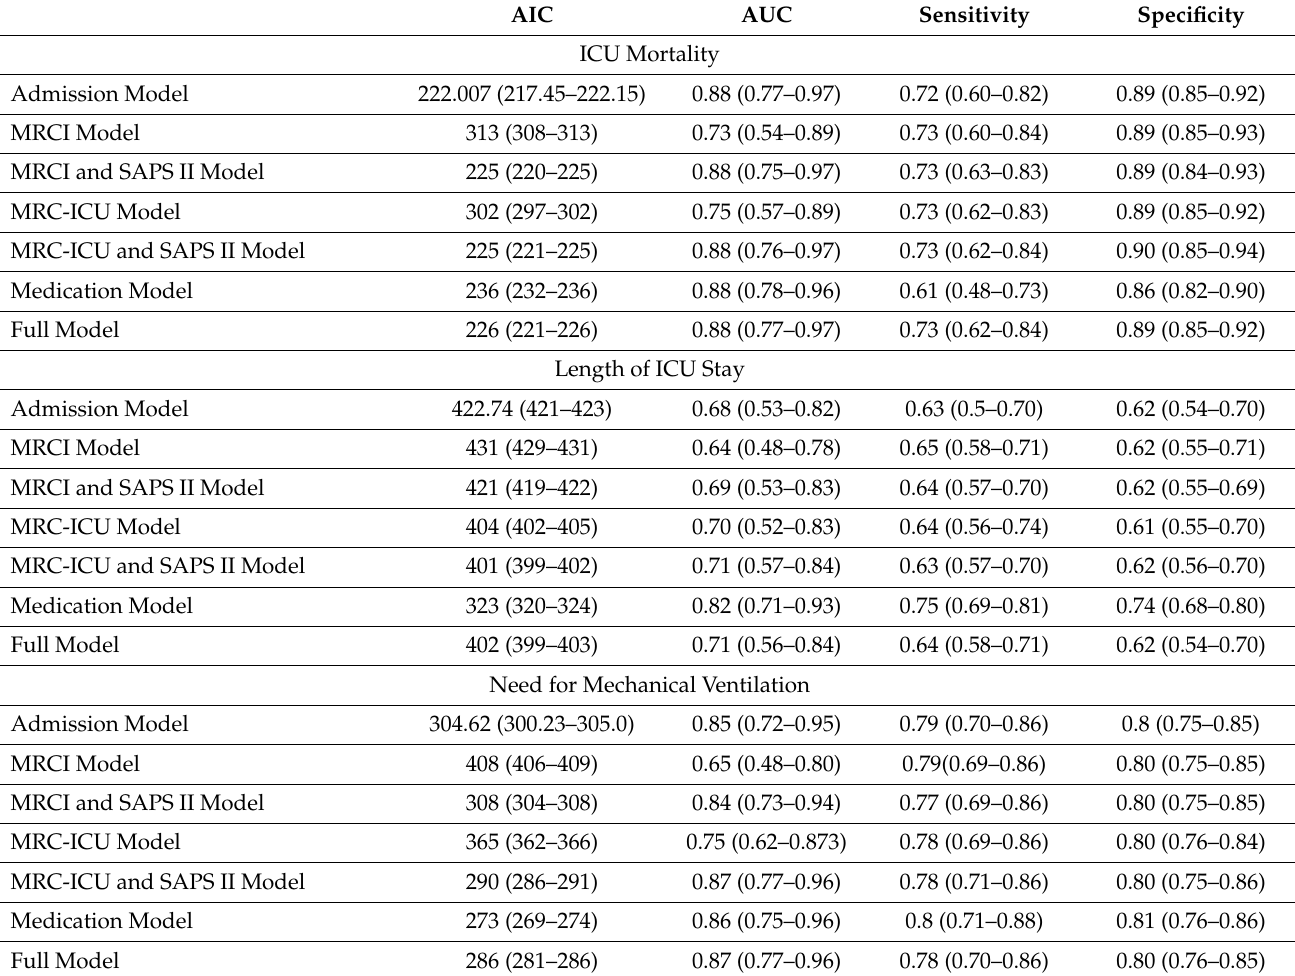
Table 3. Comparison of the prediction models. Prediction evaluation for ICU mortality, LOS, and need for mechanical ventilation. (The best 3 prediction results are noted in bold font, and demographic variables are included in each of the